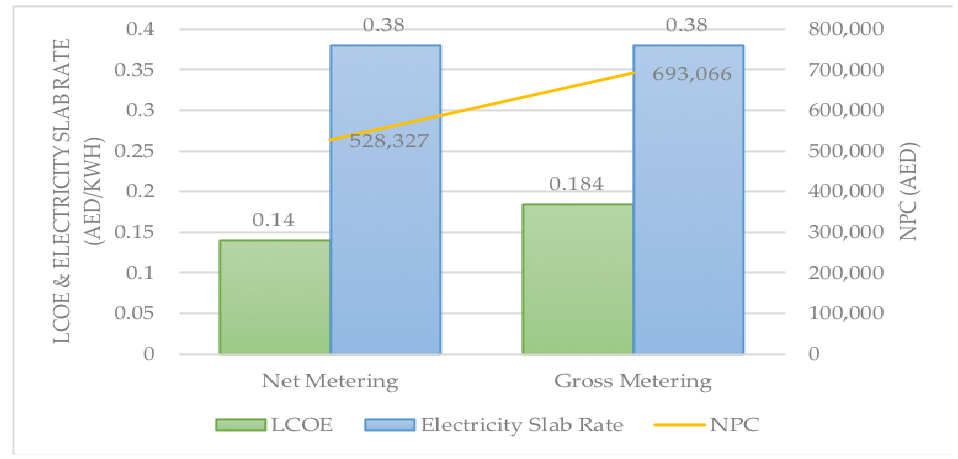
Figure 8. Cost Characteristics of Grid-Connected PV System.